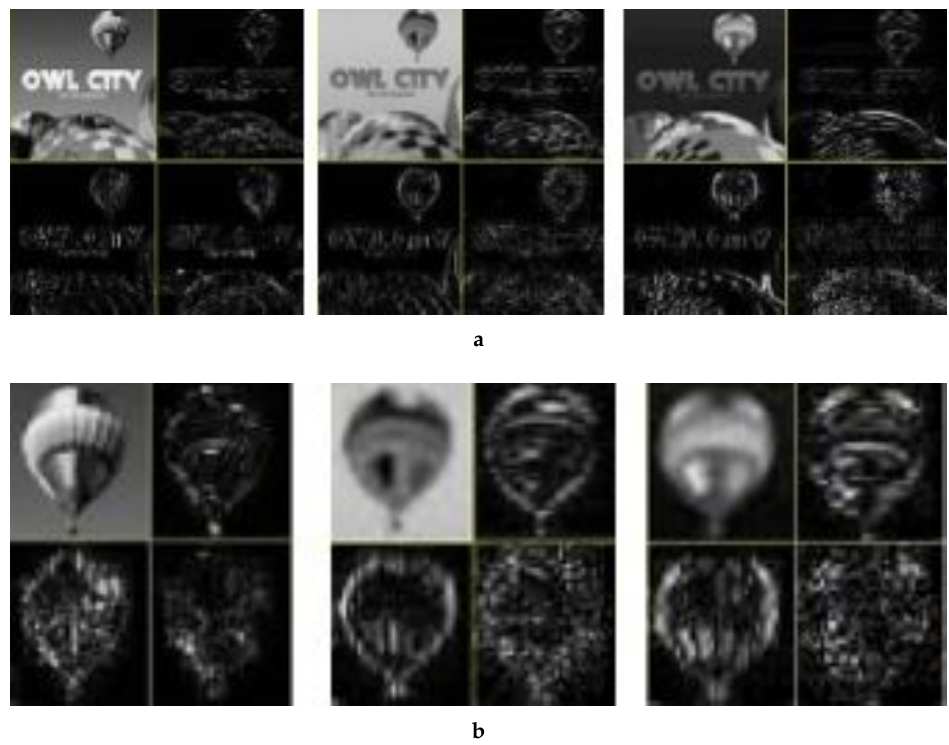
Figure 7. Level-1 wavelet-transformed YCbCr components. ( a ) Original Image, ( b ) Patch